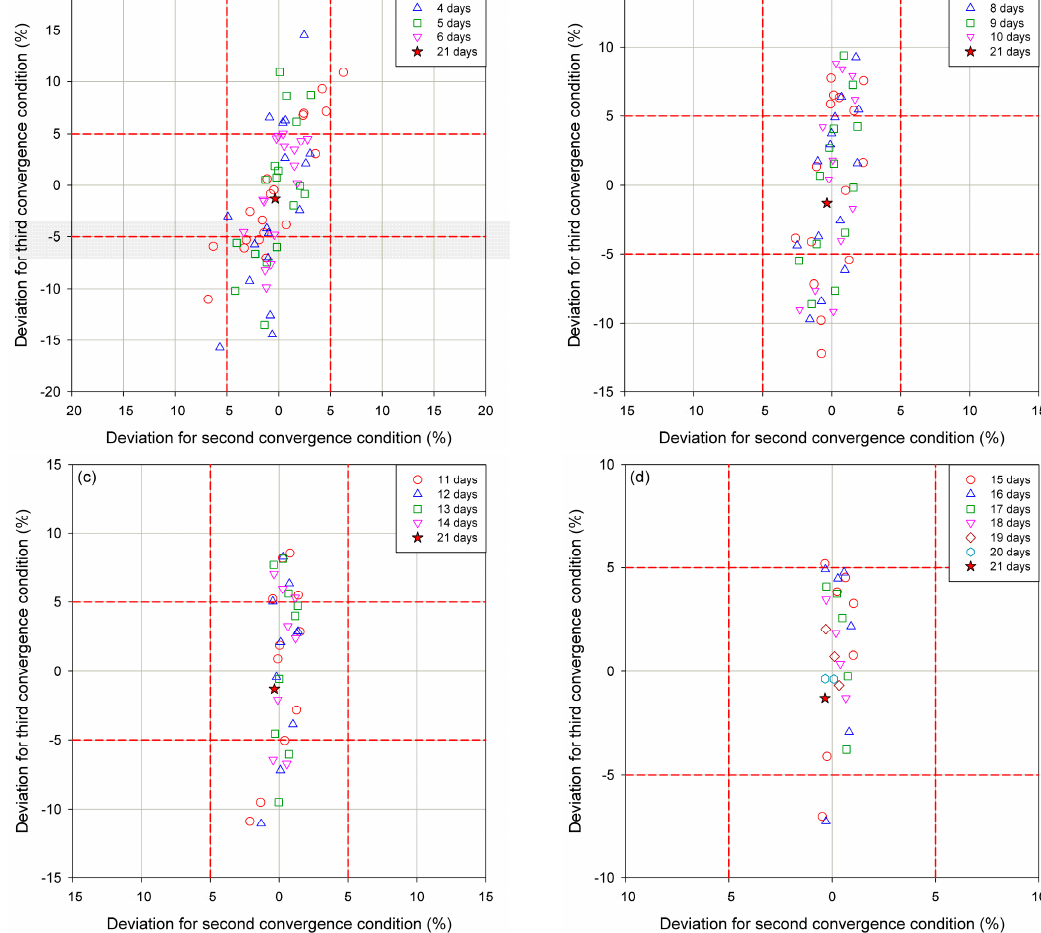
Figure 7. Convergence characteristics of U -values evaluated for different analysis periods according to conditions of the ISO 9869-1 standard. For ease of understanding, the plots are divided into four sub-figures based on the length of the analysis period: ( a ) 3–6 days; ( b ) 7–10 days; ( c ) 11–14 days; ( d ) 15–20 days.